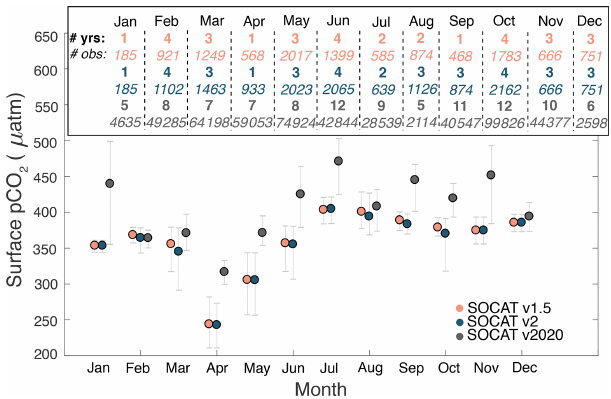
Figure 10. Comparison of the seasonal cycle of p CO 2 for the dif- ferent versions of SOCAT for the Scotian Shelf, mapped to year 2006. The points indicate the mean for each month, and the bars in- dicate the 5th and 95th percentile. Inset shows the number of years and number of observations used in each month for each